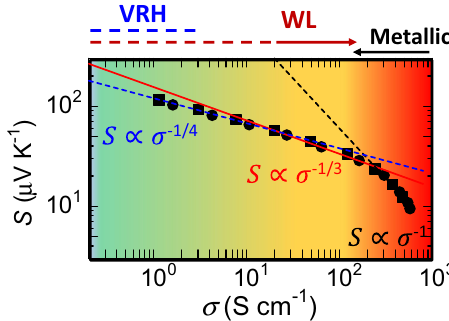
Fig. 5 Thermoelectric property of the polymer as a function of conductivity. Electrical conductivity σ dependence of the Seebeck coef fi cient S at room temperature obtained with the electrolyte gating technique reported previously 13 . Variable-range hopping (VRH), weak localization (WL) and effectively metallic regimes according to the room temperature σ values are denoted on top of the fi gure based on the conductivity and magnetoconductivity measurements. We can fi nd a narrow σ range where the σ – S relation follows S ∝ σ − 1/3 between 20 < σ < 200 S cm − 1 (solid red line), which corresponds to the σ range where WL conduction is